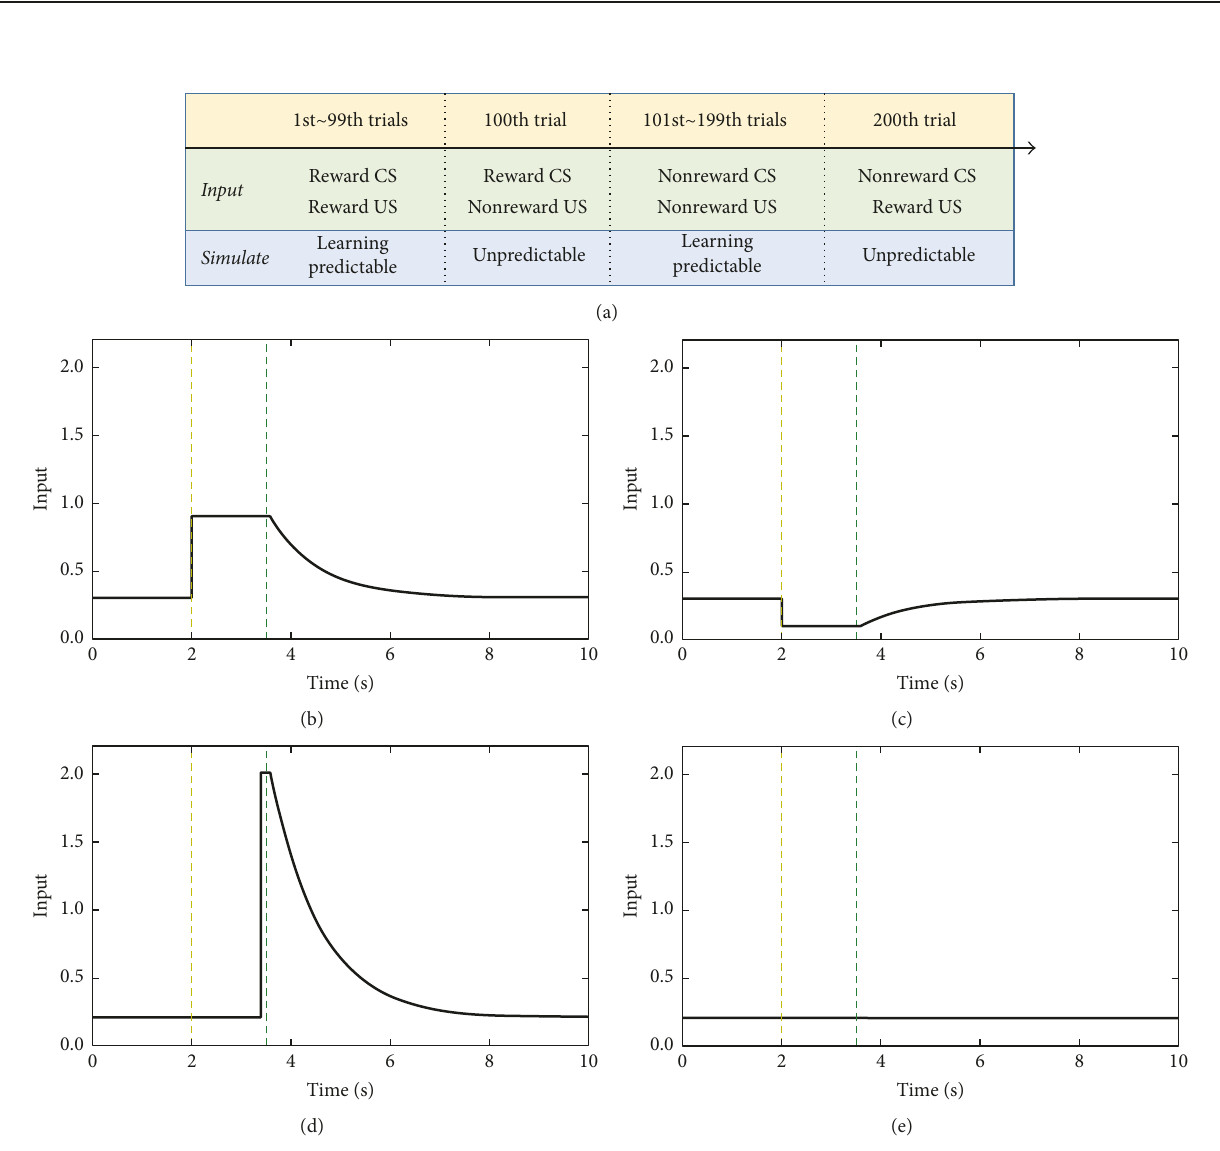
Figure 3: Model simulation protocol. (a) Different inputs are applied to simulate different conditions. We simulated a total of 200 trials. In the first 99 trials, we present reward CS input and reward US input to simulate the learning process, which associates the reward CS with the reward US. In the 100th trial, we present reward CS input but nonreward US input; thus, one predicts a reward but does not receive it. In the next 99 trials, we present nonreward CS input and nonreward US input to simulate the learning process, which associates the nonreward US with the nonreward CS. In the 200th trial, we present nonreward CS input but reward US input, simulating the situation where one predicts nonreward but receives it. (b) ∼ (e) Different inputs. The yellow dashed line indicates the time at which CS appears (2.0s), and the green dashed line indicates the time at which rewards are released or not (3.4 s). (b) Reward CS input. (c) Nonreward CS input. (d) Reward US input. (e) Nonreward US